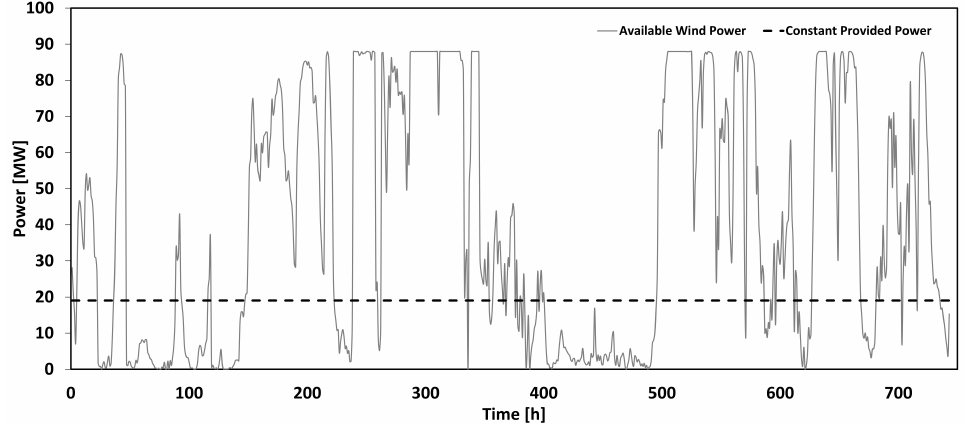
Figure 6. Constant power supply from wind